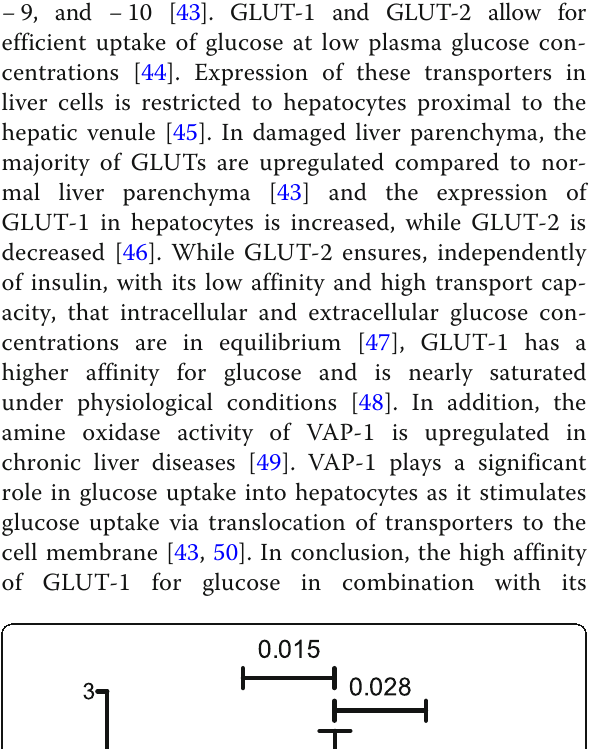
Table 3 Differentiation between the stages of liver fibrosis